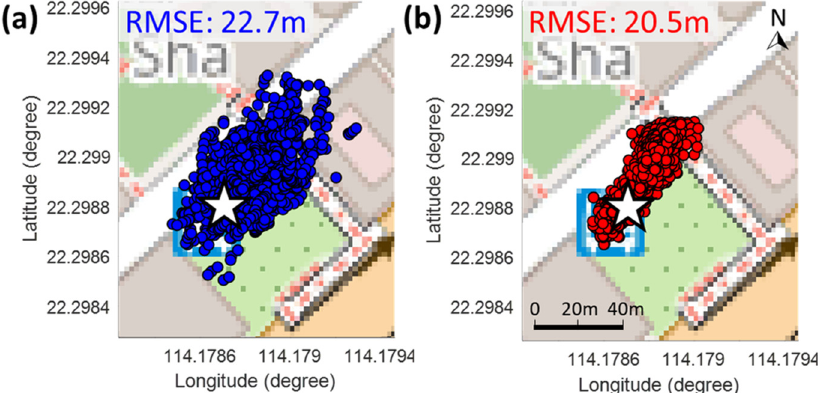
Figure 16. The least squares positioning solution based on ( a ) real received GNSS measurement; ( b ) simulated GNSS measurement from the proposed simulator. The corresponding 2D positioning root-mean-square errors (RMSEs) are shown within subfigures.